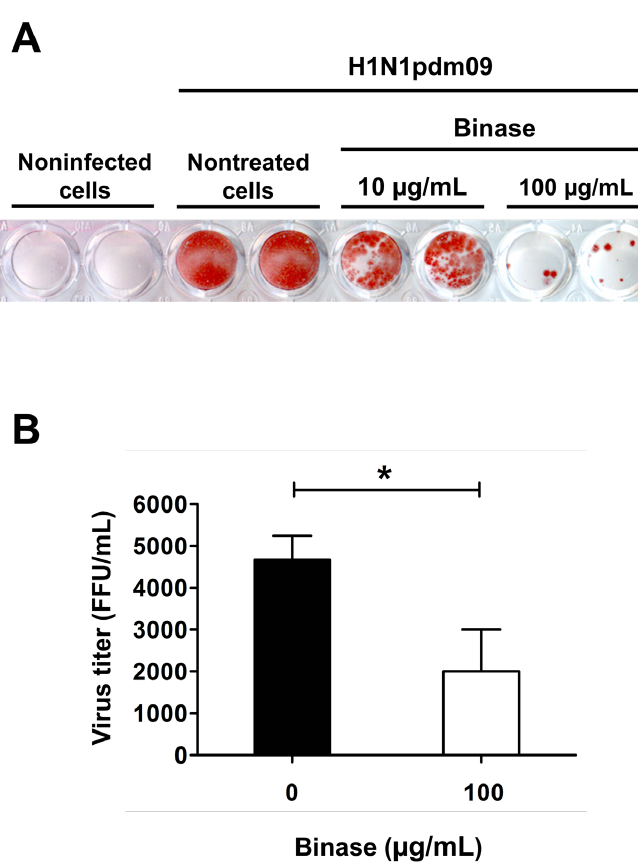
Figure 1. Detection of the influenza virus in the infected A549 cells. ( A ) The virus titer in the supernatant of H1N1pdm09-infected A549 cells (multiplicity of infection (MOI) = 1) treated with or without binase (10 4 and 10 5 U/mL) for 8 h postinfection (p.i.) was determined by a focus assay ( n = 3 × 2). Infected MDCK-II cells are stained red. ( B ) The antiviral effect of binase was quantified, showing that the binase treatment reduced the virus titer by 57% (* p < 0.05).